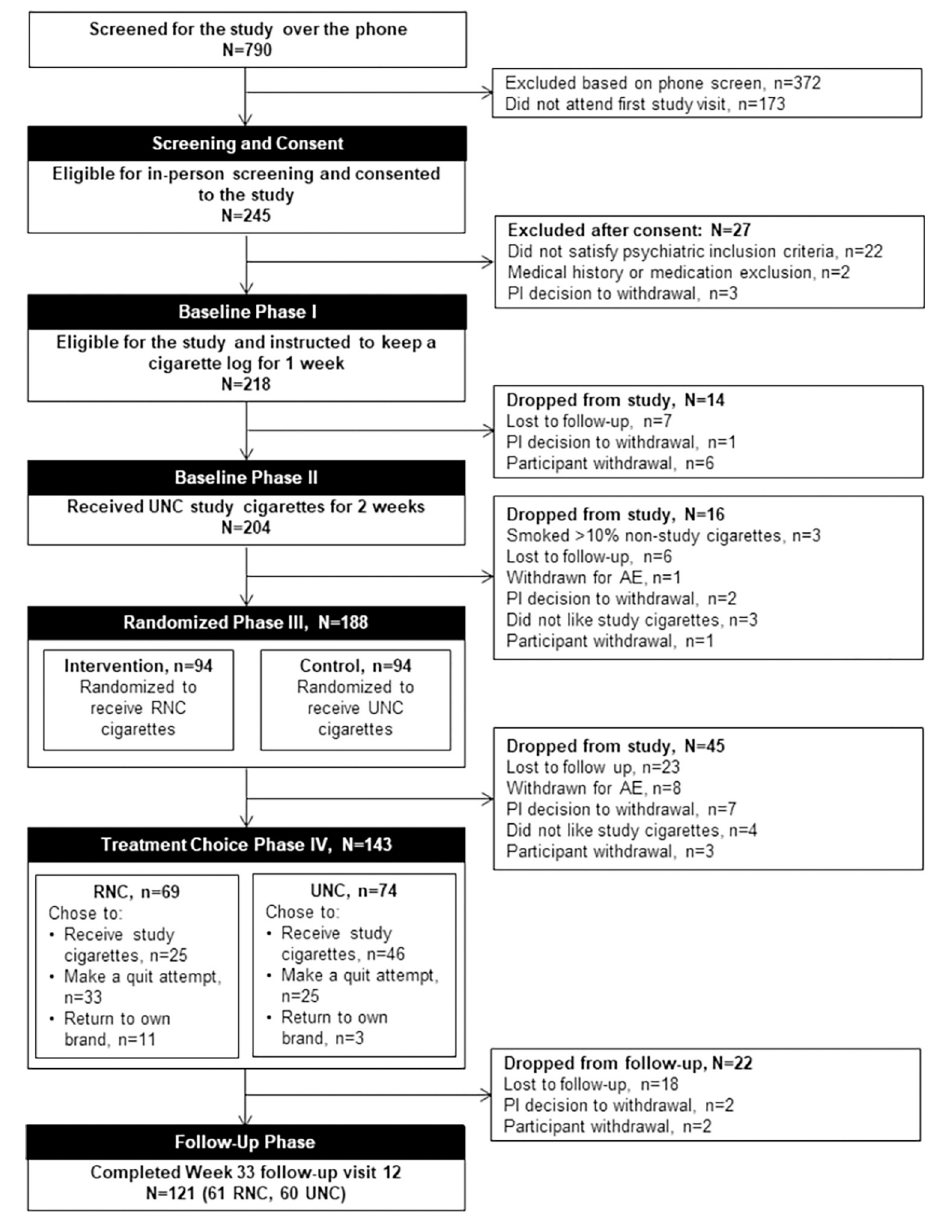
Fig 1. CONSORT participant flow